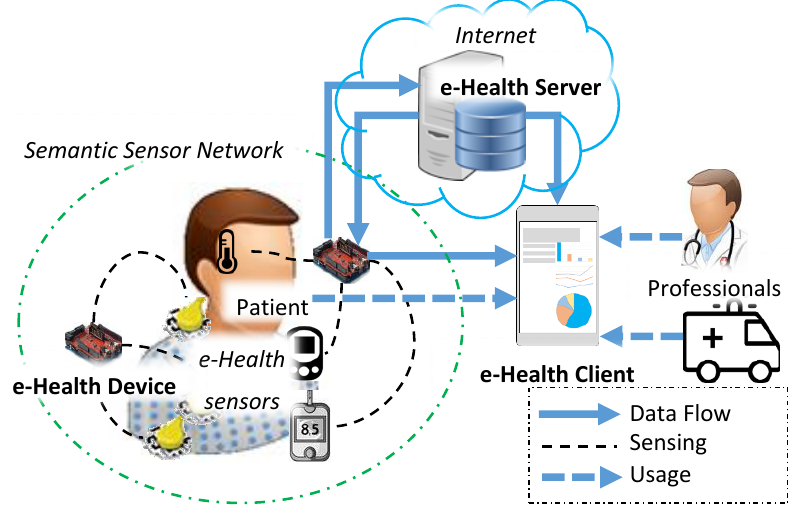
Figure 1. Proposed healthcare system components.